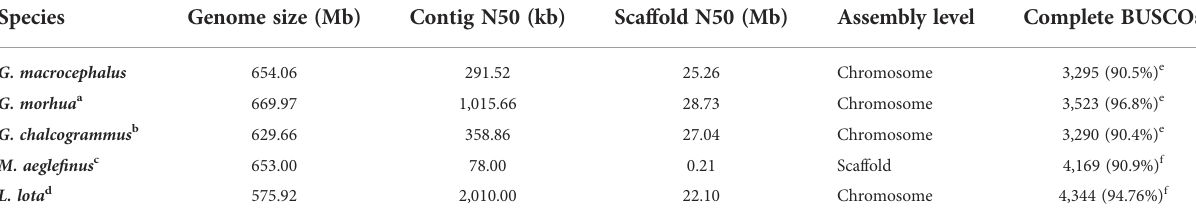
TABLE 1 Comparison of assembly statistics for the G. macrocephalus and other Gadidae species genome.